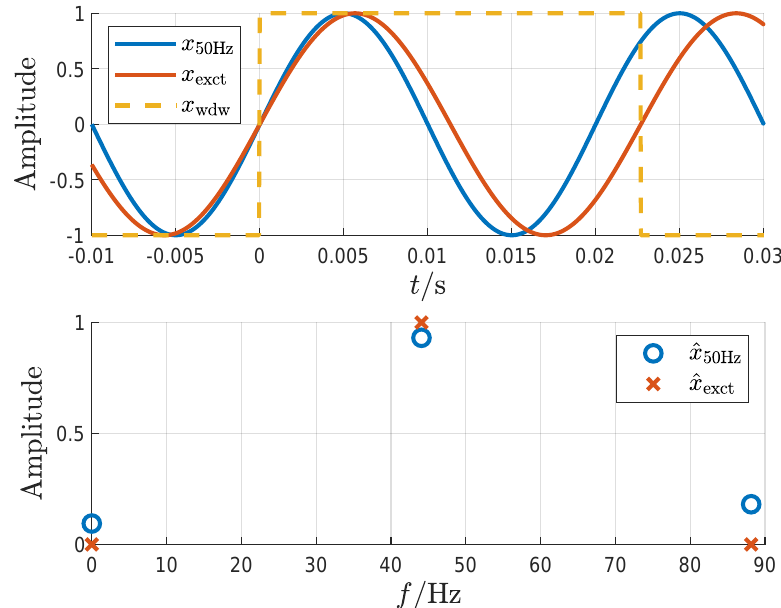
Figure 6. Illustration of the spectral leakage effect due to improper window size of the